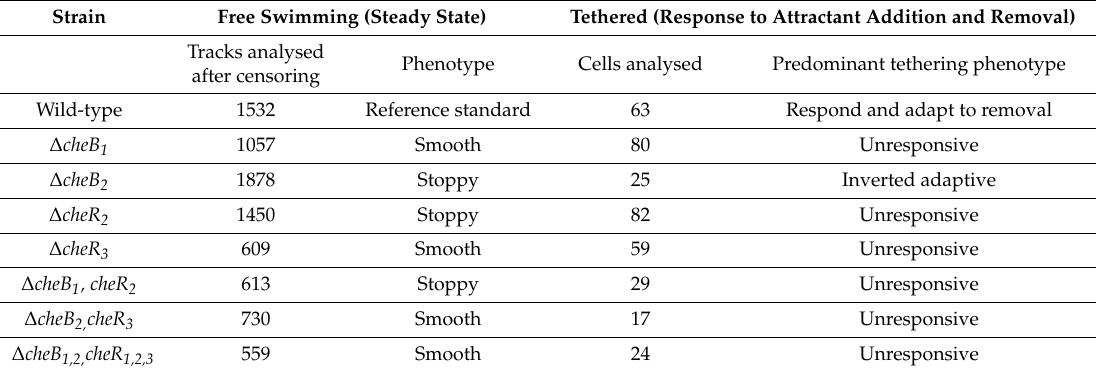
Table 2. Free swimming and tethering phenotypes for CheB and CheR deletion mutants. In all populations tested, a small percentage of cells showed no response under any condition. Strain Free Swimming (Steady State) Tethered (Response to Attractant Addition and Removal) Tracks analysed Phenotype Cells analysed Predominant tethering phenotype after censoring Wild-type 1532 Reference standard